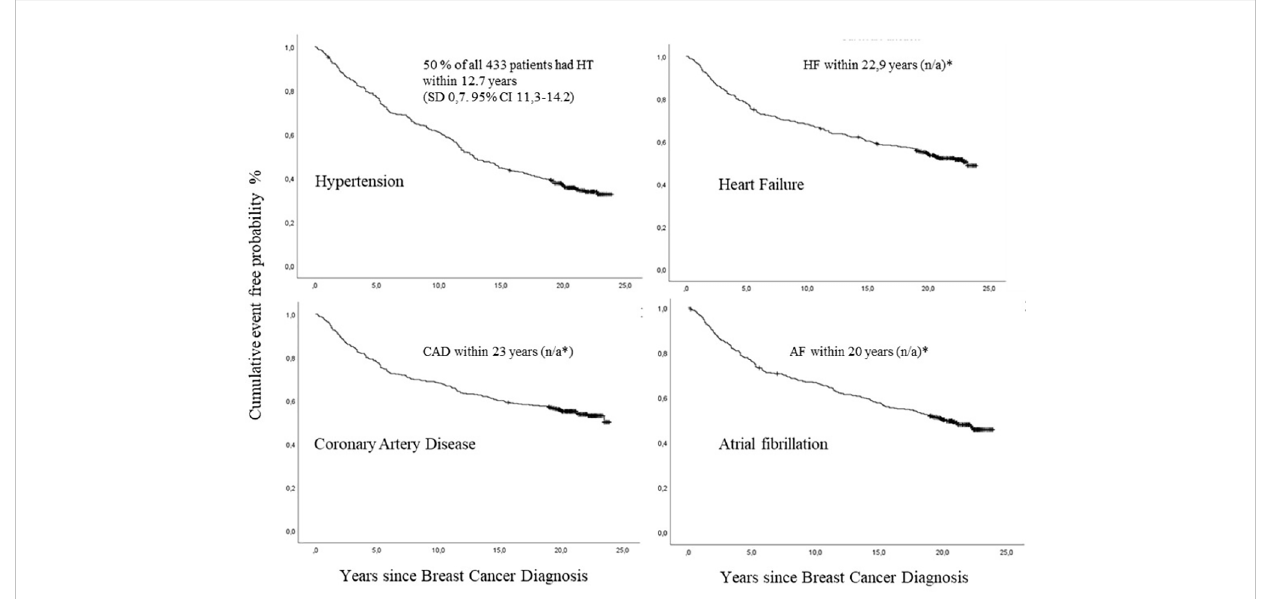
FIGURE 3 Cumulative incidence of hypertension (HT), coronary artery disease (CAD), heart failure (HF) and atrial fi brillation (AF) after breast cancer (BC) diagnosis by number of years since diagnosis, among 433 patients with lymph node-positive early breast cancer, with death as a competing risk, in the Southeast Healthcare Region, Sweden, January 1, 1998, to December 31,